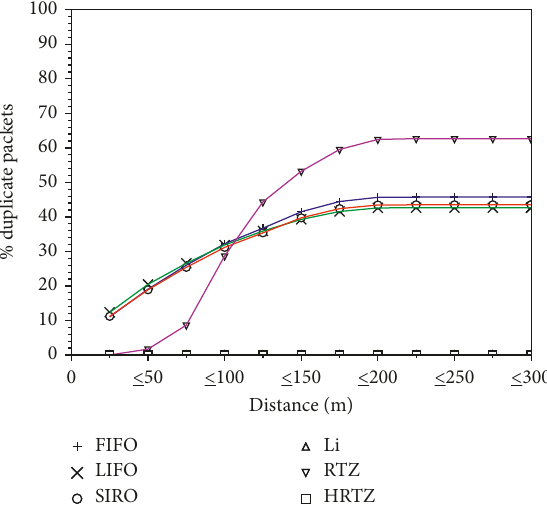
Figure 9: The cumulative percentage of the received duplicated messages from neighboring vehicles across distances at a receiving vehicle’s